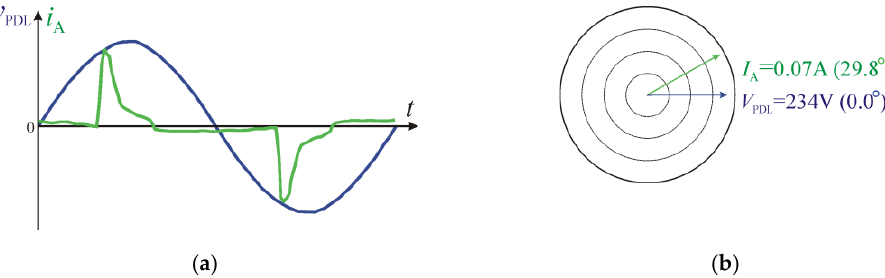
Figure A5. Experimental measurements at the point of connection 1500 lm 3000 K LED light bulb to power distribution lines: ( a ) Voltage and current time diagrams; ( b ) Voltage and current phase diagrams defined for first harmonic.